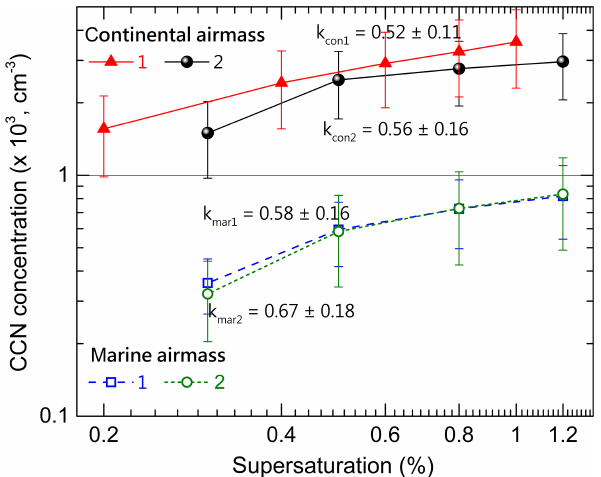
Figure 4. Mean CCN concentrations ( ± SD) for different SS during continental and marine conditions. The power law fit k value of each spectrum is also